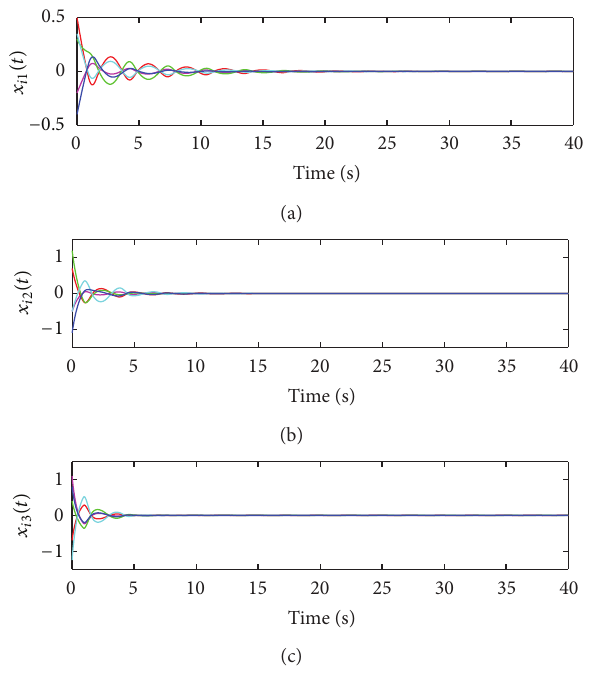
Figure 1: Synchronization state curves for the dynamic nodes delayed network (65) with 𝑐 = 0.5 and ℎ(𝑡) = 0.5 + 0.715| cos 𝑡| .